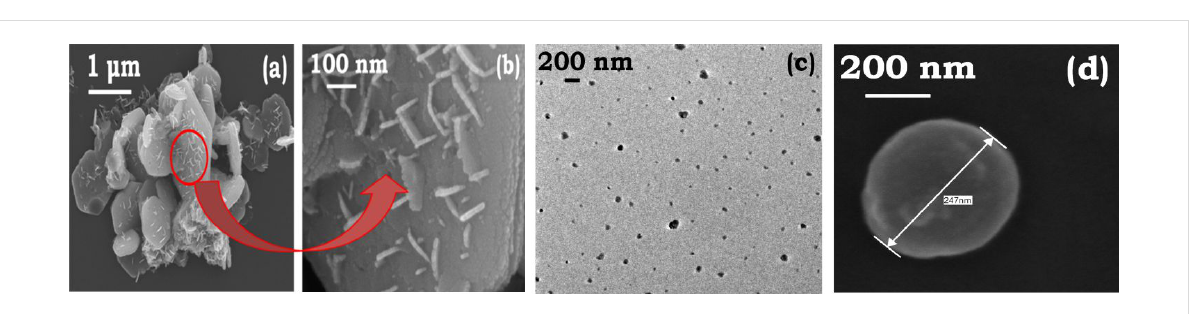
Figure 10: Manipulation of morphologies by TEAH and TBAH. (a,b) FEGSEM micrographs show cobalt-TEAH captured after 45 min. Micrographs show that small nanoplates of 70 nm diameter are formed on a bigger hexagonal base plate with typical 1000 nm edge length; (c,d) FEGTEM and FEGSEM micrographs captured after 45 min of the cobalt-TBAH system show the formation of nearly spherical nanoparticles. The presence of larger cation inhibits anisotropic growth in the TBAH system.